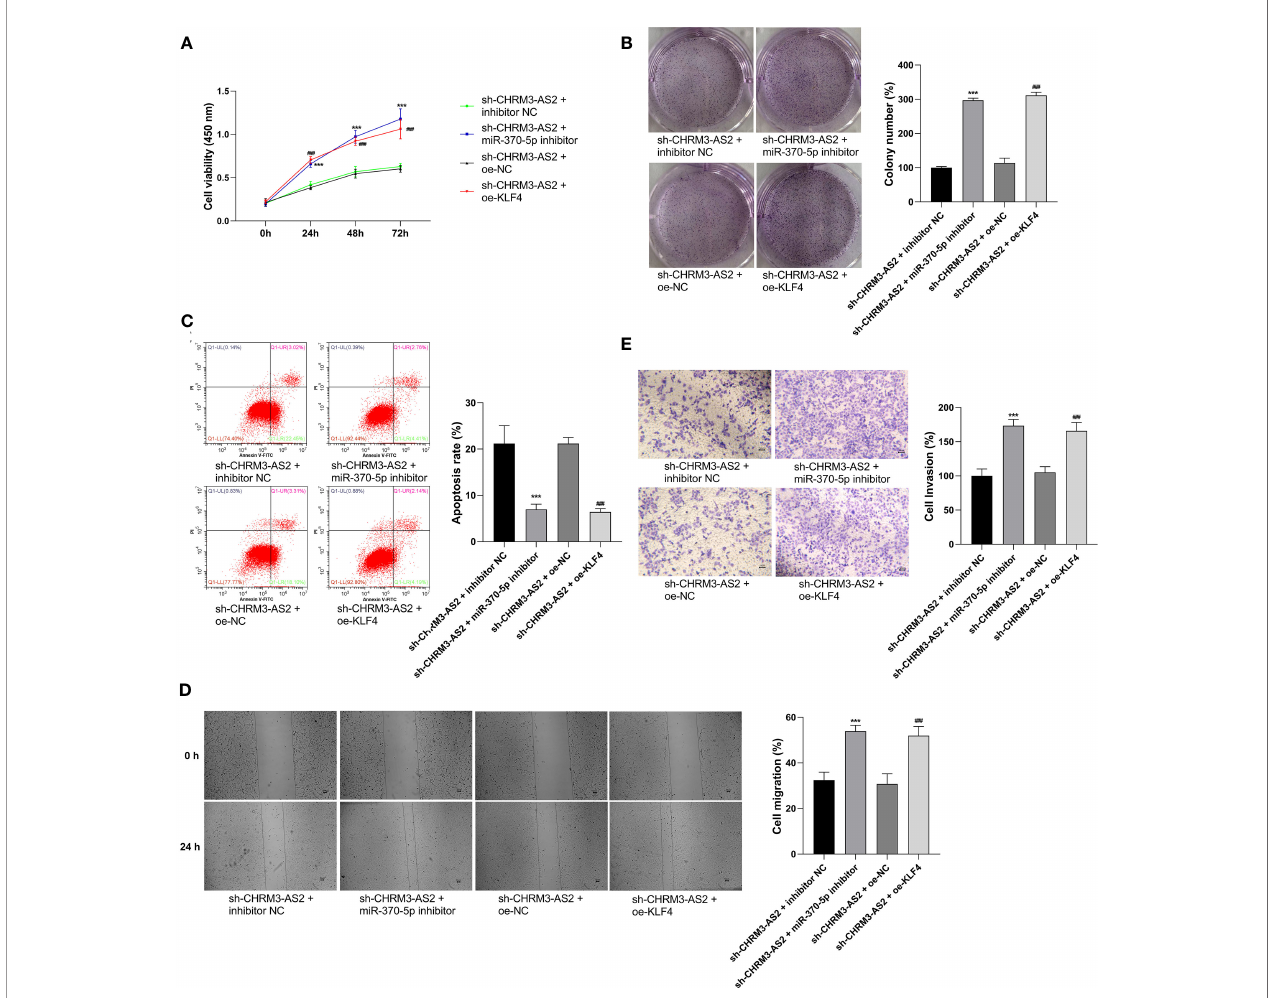
FIGURE 6 | Regulatory role of CHRM3-AS2/miR-370-5p/KLF4 axis in malignant characteristics of glioma cells. (A) Cell viability was evaluated via CCK-8 assays. (B) Colony numbers were quanti fi ed via colony formation assays. (C) Cell apoptosis was evaluated via fl ow cytometry. (D) Cell migration was evaluated via wound healing assays. (E) Cell invasion was evaluated via Transwell assays. U251 cells were co-transfected with sh-CHRM3-AS2 and miR-370-5p inhibitor/inhibitor NC or oe-KLF4/oe-NC. ***P < 0.001 vs. sh-CHRM3-AS2 + inhibitor NC; ### P < 0.001 vs. sh-CHRM3-AS2 +